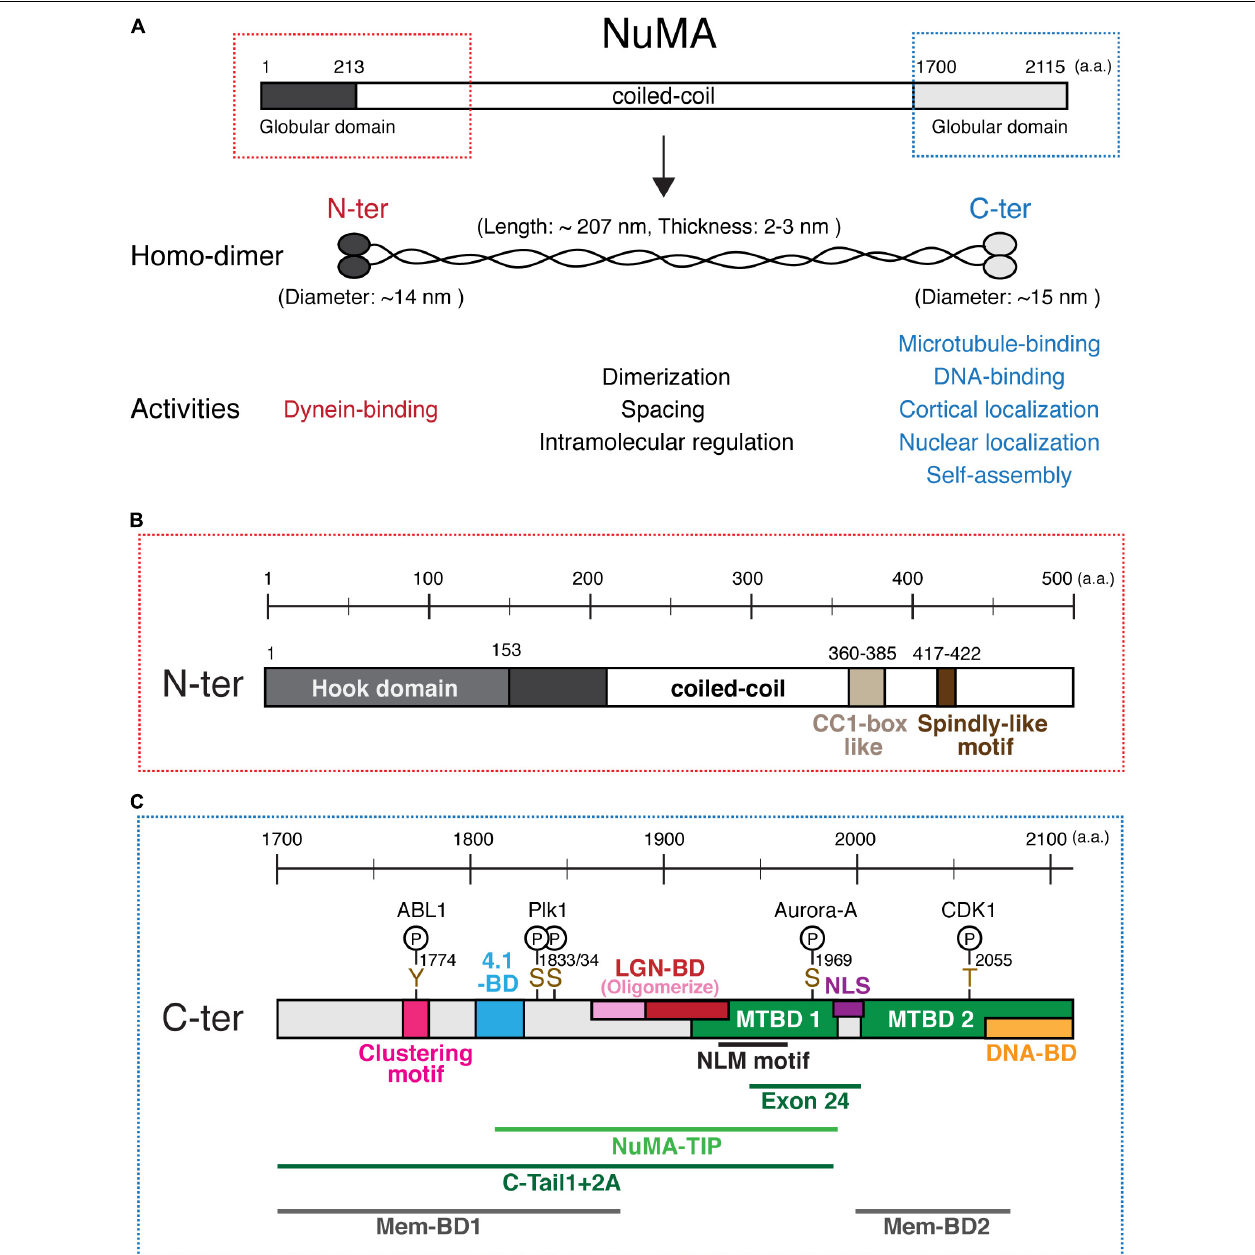
FIGURE 2 | NuMA’s domain structure. (A) Diagrams of full length NuMA. Human NuMA isoform 1 (NP_006176) consists of 2,115 amino acids (a.a.) (Yang et al., 1992), whereas NuMA isoform 2 (NP_001273490) is lacking 14 a.a. at the 1,539–1,552 region (Compton et al., 1992). In this review, we refer to isoform 1. NuMA forms a homodimer through its central coiled-coil region. The central rod-shaped structure has an average length of ∼ 207 nm and a thickness of ∼ 2–3 nm, while N-terminal and C-terminal globular structures show a diameter of ∼ 14 and ∼ 15 nm, respectively (Harborth et al., 1995). (B) Domains in the N-terminal region. (C) Domains, motifs, phosphorylation sites, and functional regions in the C-terminal region of NuMA. See the text and Table 1 for details. NuMA 1944 − 2003 , corresponding to either exon 22 for mice or exon 24 for human, was deleted in Silk et al. (2009); Kolano et al. (2012), and Tsuchiya et al. (2021), instead of depleting the complete